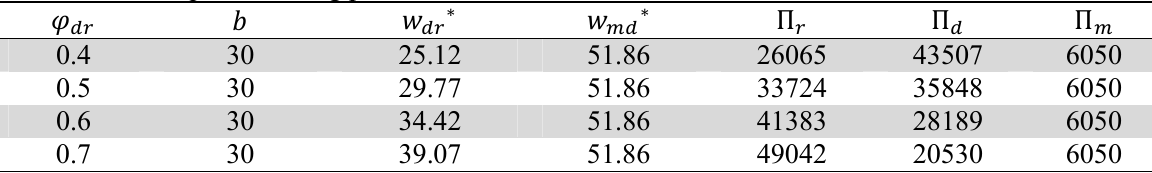
The effect of the profit sharing